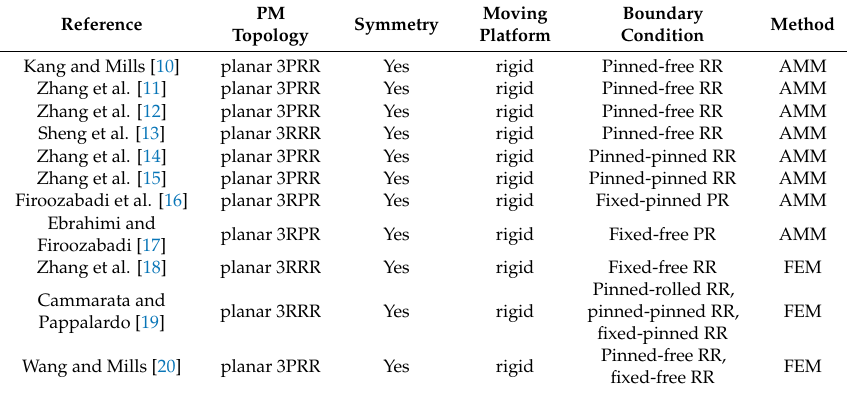
Table 1. Previous works studying the flexible body dynamics of parallel manipulators (PMs) based on floating frame of reference formulation